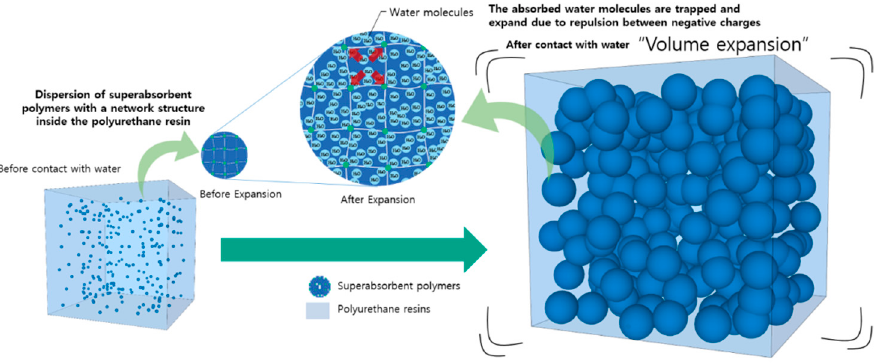
Figure 4. The expansion mechanism of polyurethane with water expansion properties.